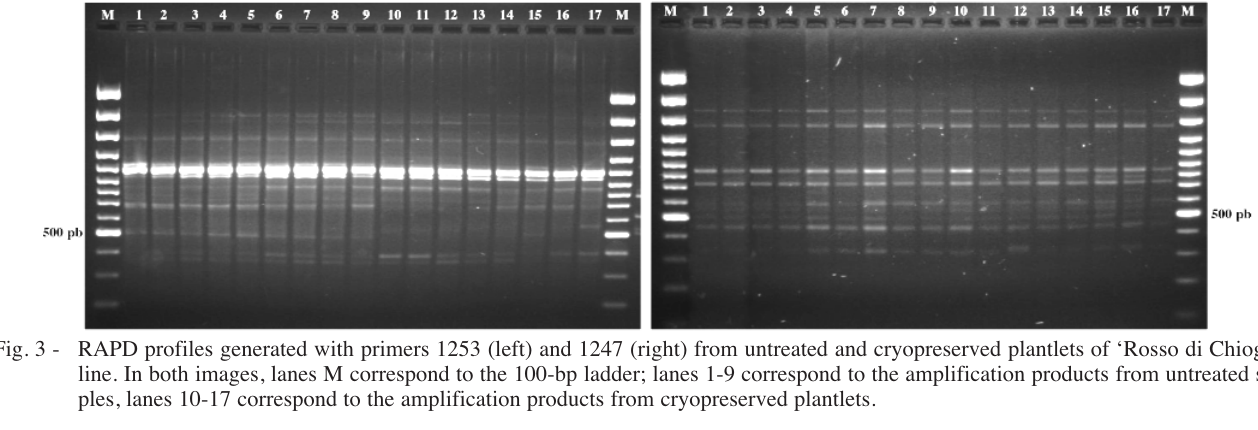
Table 6 - Shoot tip survival percentage of ‘Rosso di Chioggia’ shoot- tips after two different cryogenic procedures Cryogenic procedure Shoot tip survival (%) (z) Vitrification Encapsulation - vitrification